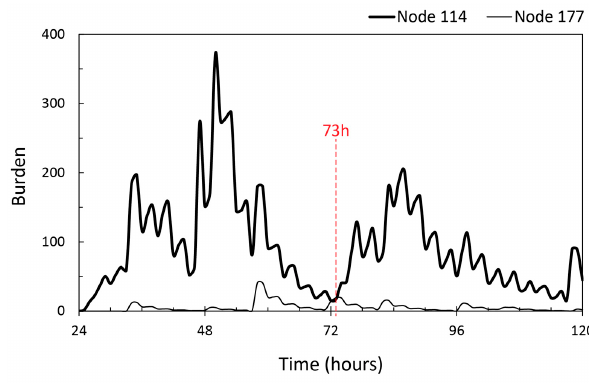
Figure 21. ReBurD’s relative burden against time for Node 114 and 177.